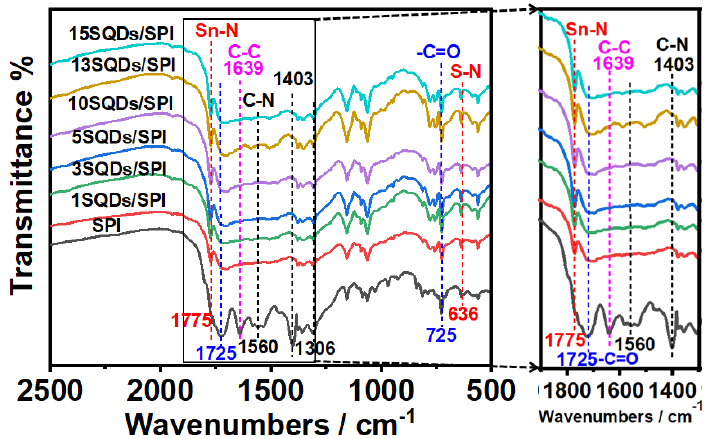
Figure 3. FT ‐ IR spectra of SPI and SQDs/SPI composites. Figure 3. FT-IR spectra of SPI and SQDs/SPI